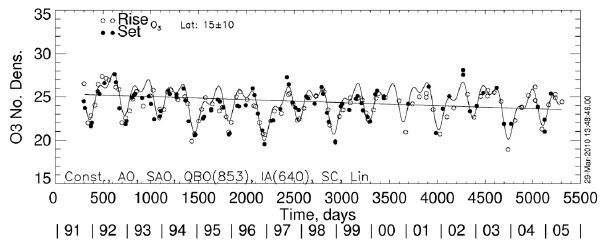
Fig. 4. As in Fig. 2, but for 15 ◦ N and 32.5km.